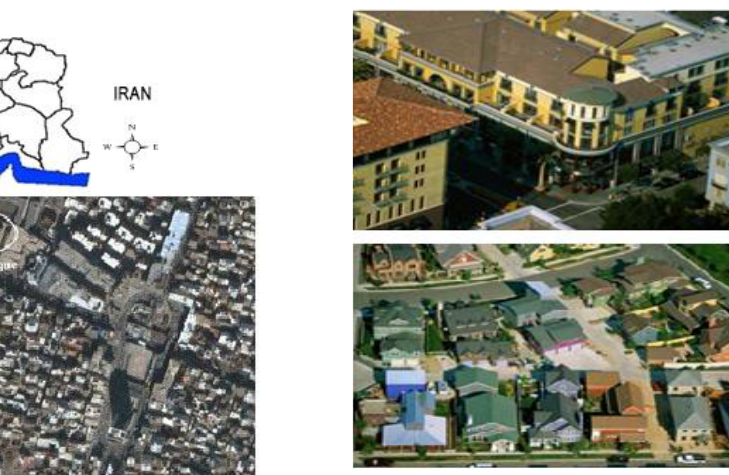
Fig. 2: Apartments allowed over shops and Garages located on alleys (Lincoln